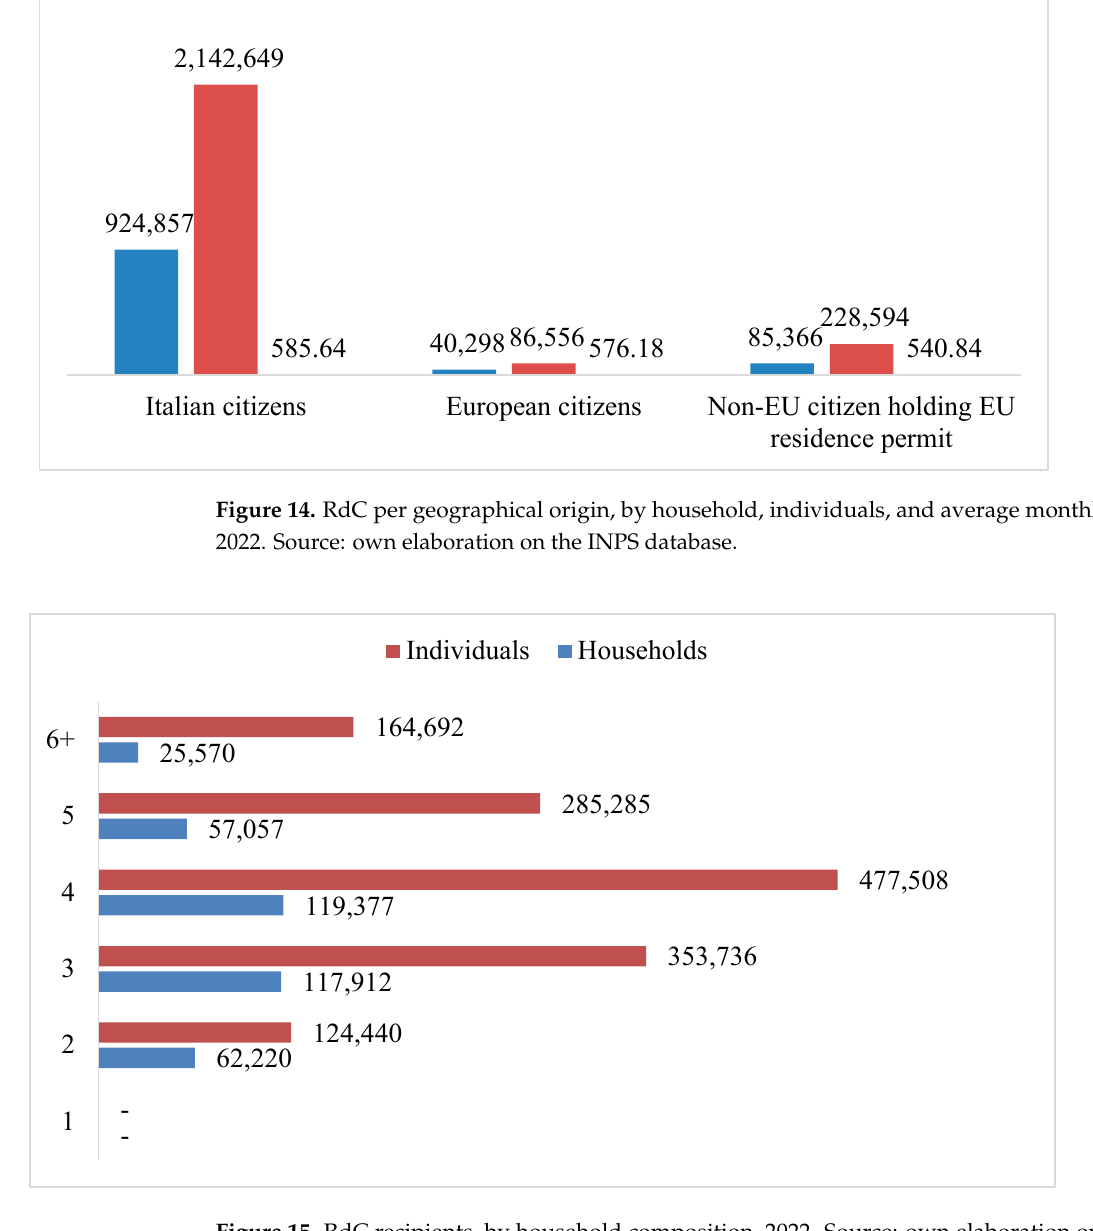
Figure 15. RdC recipients, by household composition, 2022. Source: own elaboration on the INPS